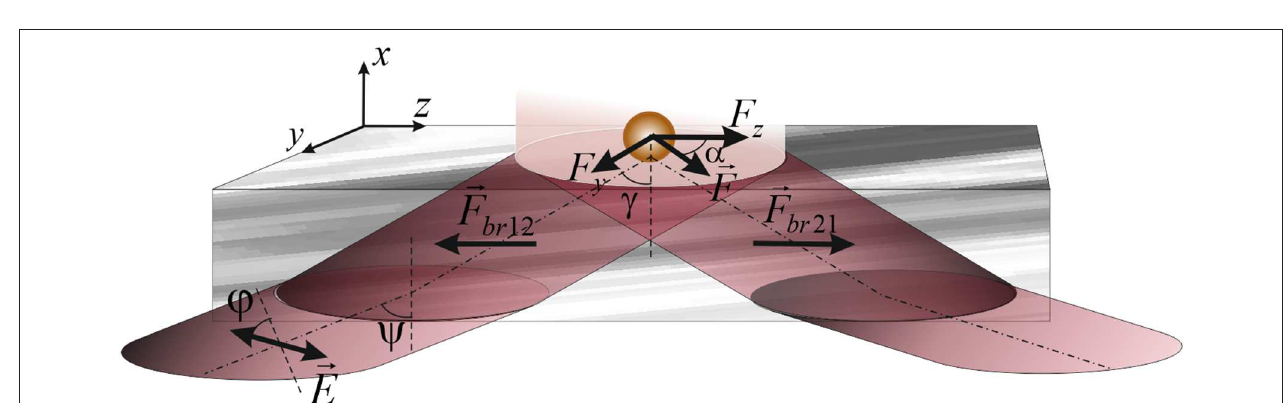
FIGURE 1 | Scheme showing the propagation of a beam through the birefringent section of biotissue during the formation of vertical spin of an evanescent wave above the surface of the section. Here, ϕ , the azimuth of polarization of the probing beam; 9 the angle of incidence of the probing beam, γ , the angle determining the propagation direction of the incident beam. E F br 21 , optical force directed to the external surface of the section and E F br 21 , optical force acting in the opposite direction. F y , F z , the components of the optical force E F determined by the action of the evanescent wave on the gold particles above the surface of the section, the resultant of which determines the direction of the particles motion ( α ).